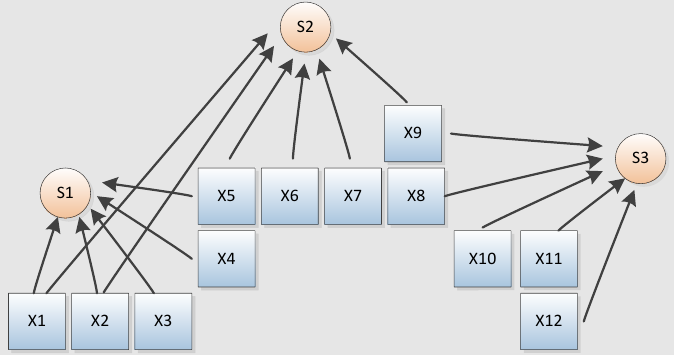
Figure 2. Simplified model of radiation emission from the shelter object.